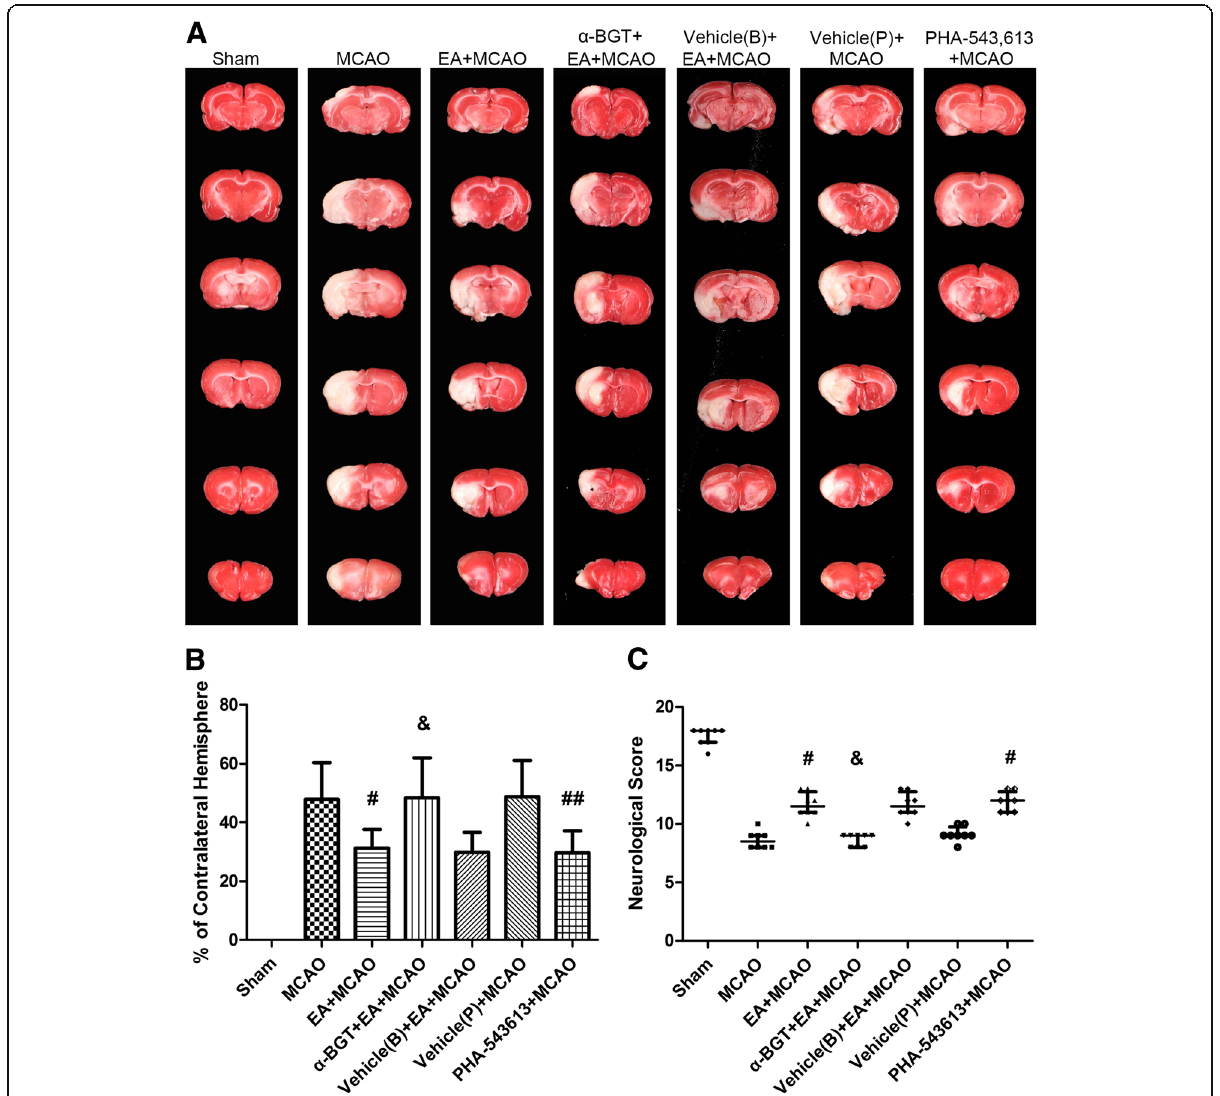
Fig. 8 α 7nAChR was involved in the neuroprotective effects of EA stimulus. Representative TTC staining of the cerebral infarct ( a ), infarct volume ( b ) and neurologic score ( c ) at 3days after reperfusion ( n =8). Red area represents live tissue; and white area represents dead or dying tissue. The infarct volume of EA+MCAO group was significantly reduced and the neurological score was improved when compared with MCAO group. Compared with EA+MCAO group, the infarct volume of α -BGT+EA+MCAO group was significantly increased and neurological score was reduced. When compared with MCAO group, intraperitoneal injection of PHA-543,613 decreased the infarct size and alleviated neurological deficits. # P <0.05, ## P <0.01 vs. MCAO group, & P <0.05 vs. EA+MCAO